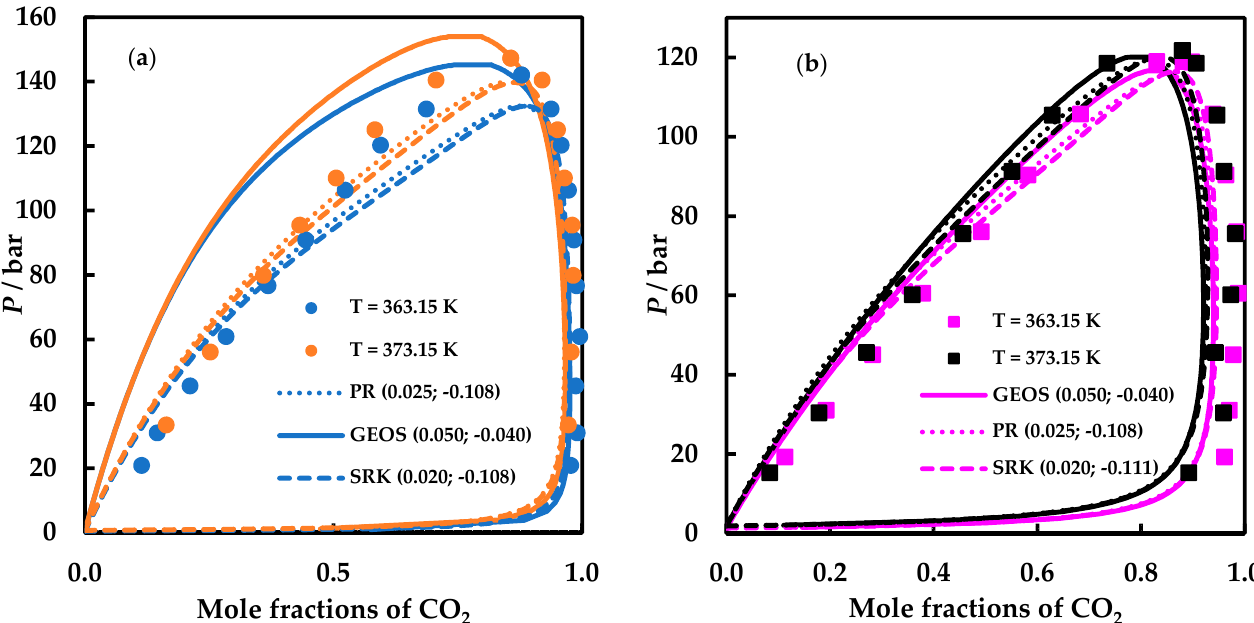
Figure 8. Comparison of new data and predictions by GEOS (full lines), PR (dotted lines), and SRK (dashed lines): ( a ) carbon dioxide (1) + isobutanol (2) and ( b ) carbon dioxide (1) + tert -butanol (2).